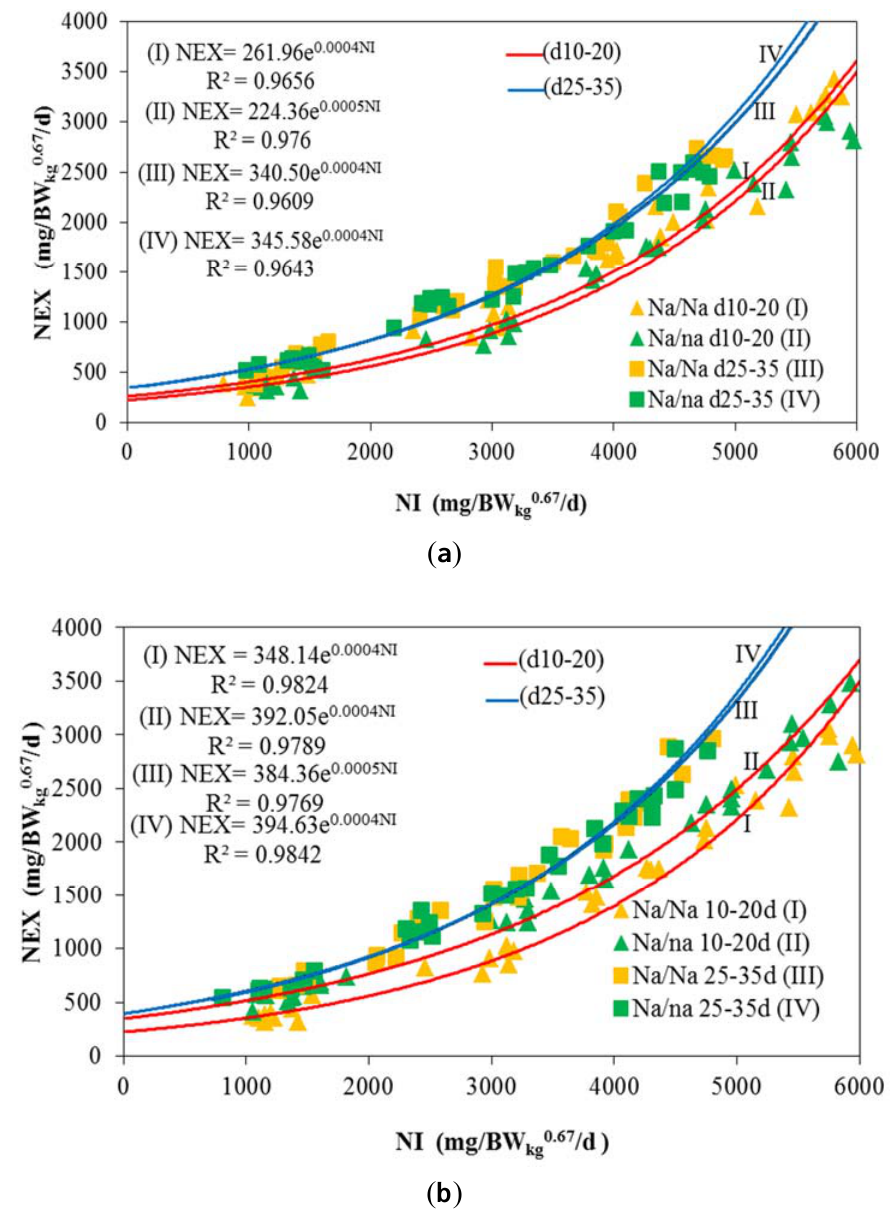
Figure 1. Estimation of N maintenance (NMR) by fitting exponential function between daily N intake (NI) and daily N excretion (NEX) following graded protein supply depending on sex, genotype and age period. ( a ) Males; ( b ) Females.